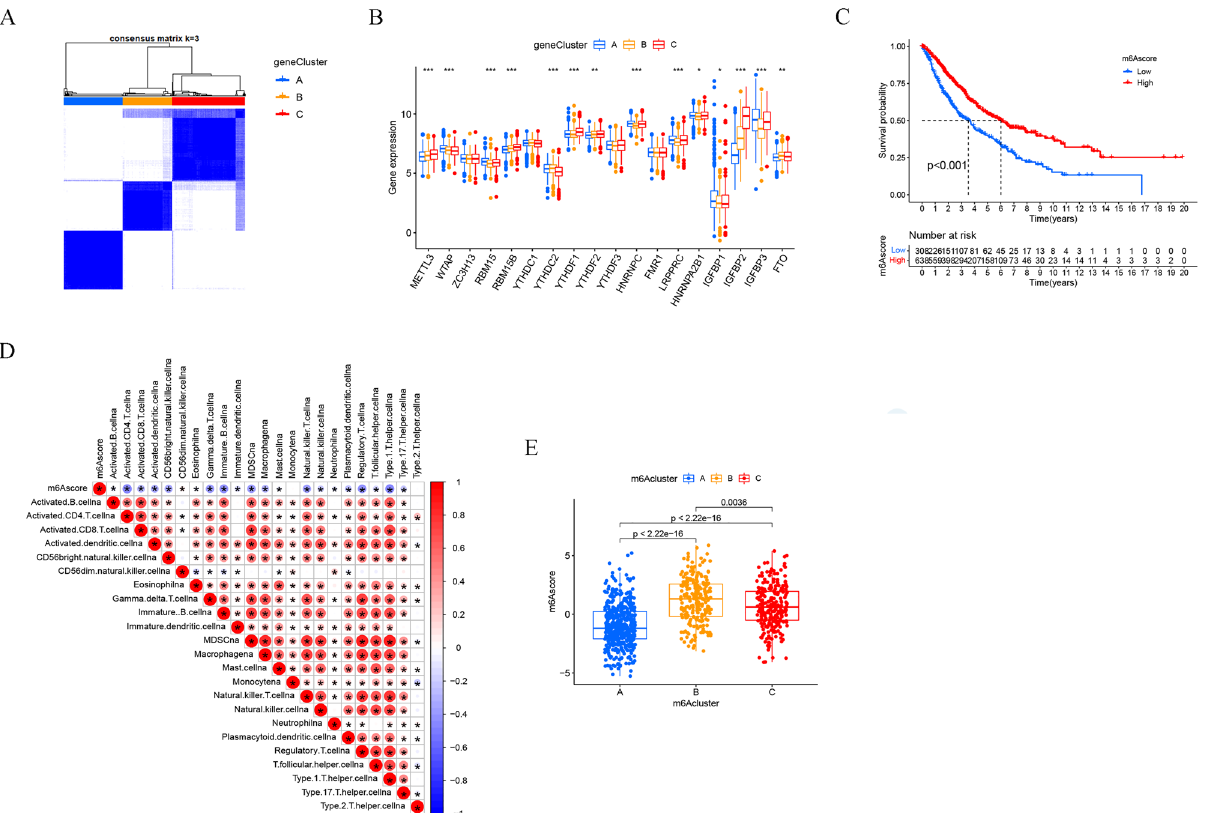
Figure 4. Generation of m 6 A signatures and m 6 Ascores. ( A ) Consensus clustering of genecluster for k = 3. ( B ) Gene expression levels of 23 m6A regulators in three m6A modification genomic phenotypes (* P < 0.05; ** P < 0.01; *** P < 0.001). ( C ) The overall survival of m6A scoring signature. ( D ) Correlation between m6Ascore and immune cell infiltration. ( E ) m6Ascore in different m6Acluster